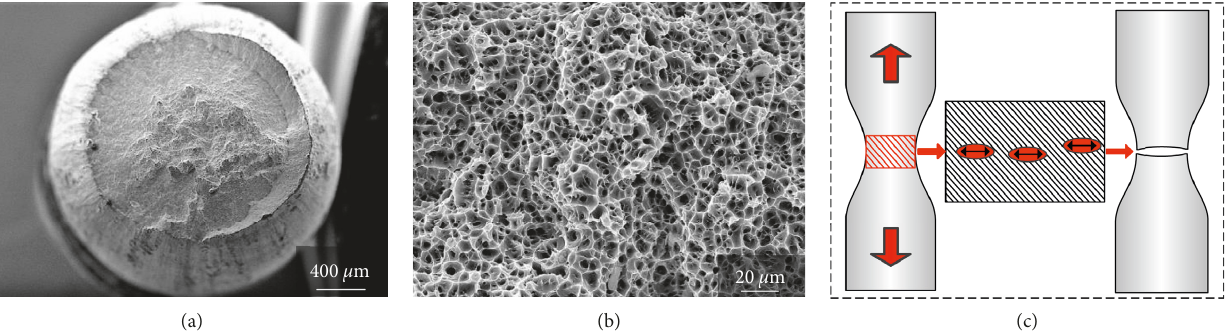
Figure 6: The fracture morphology of the ϕ 5.2 mm wire with hydrogen content of 0.23 μ g/g: (a) macroscopic morphology of the fracture; (b) microscopic view of the dimples; (c) schematic diagram of the regular fracture.